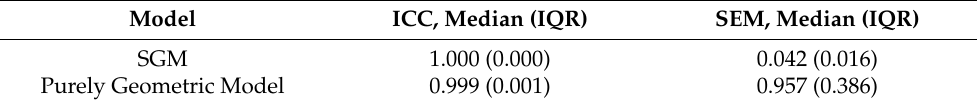
* The left column shows the mean and standard deviation of the mean values in each trial. The right column shows the mean and standard deviation of the maximum values, calculated as the 99th percentile for each trial. Knee moments are the moments associated with the gravitational, inertial, and external actions of the FDM. Positive knee moments are extensor, and negative moments are flexor. Table 3. Agreement between FDM and SGM and Purely Geometric Model *. n = 15.